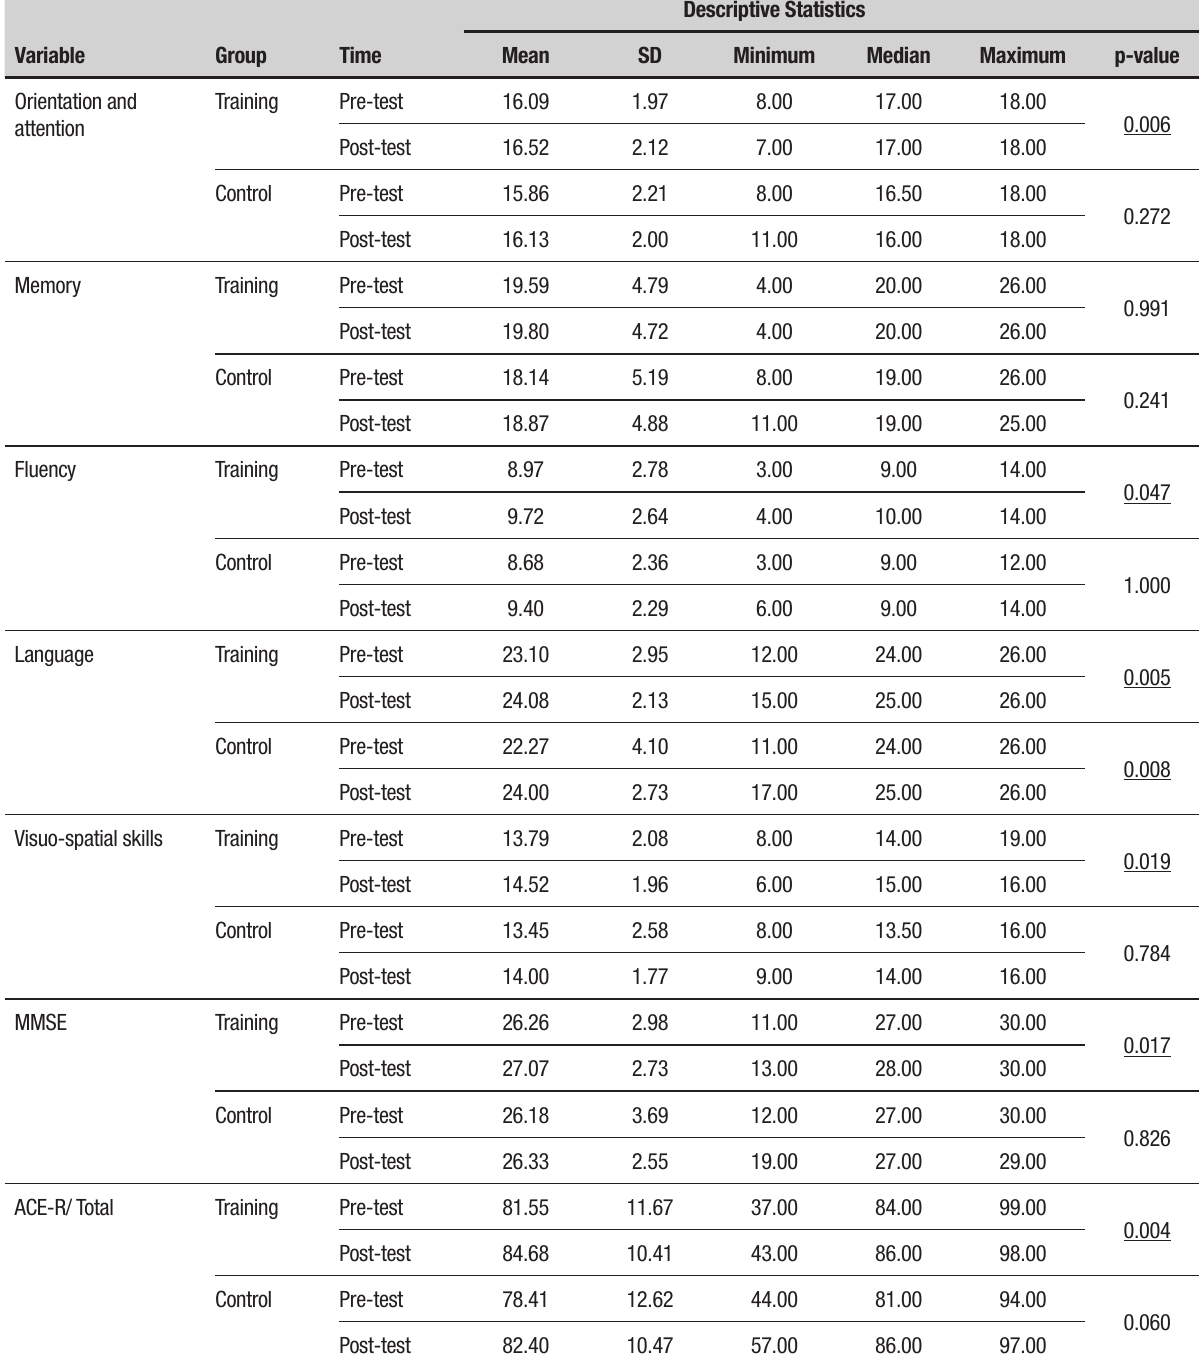
Table 2. Comparison pre and post-test between training and control